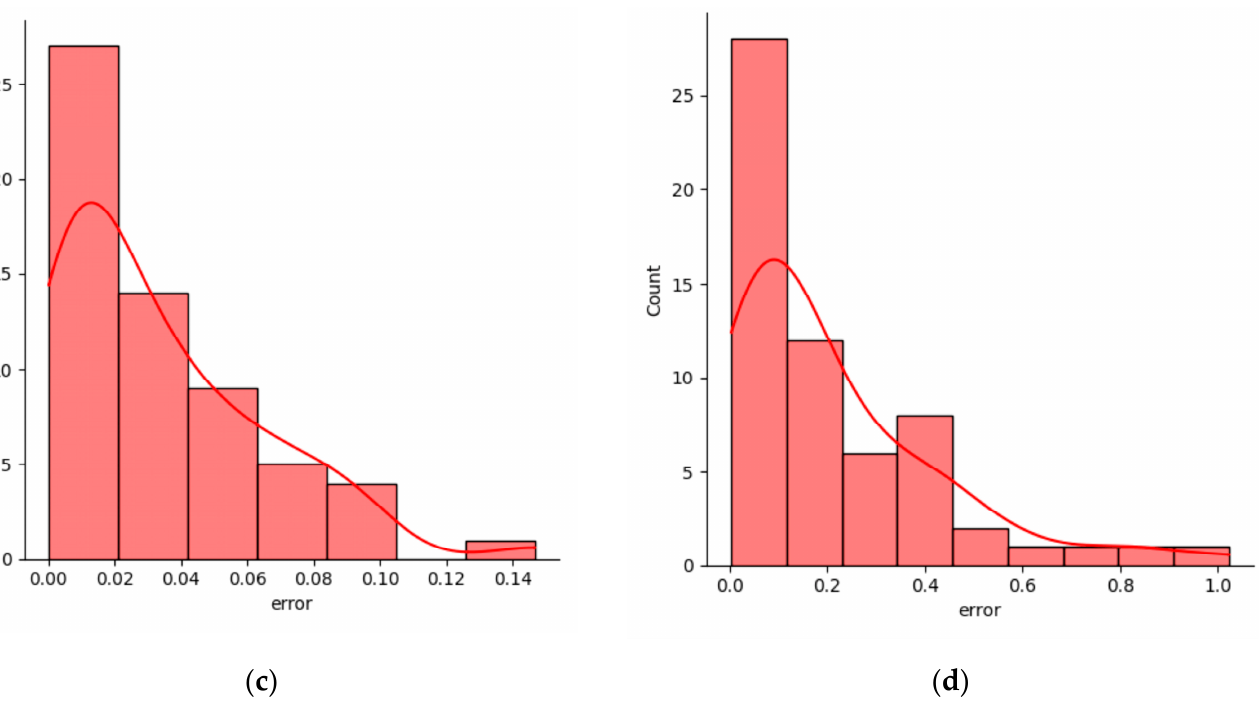
Figure 8. Histogram of the error distribution of predicted and actual values for the four datasets. ( a ) Histogram of the error distribution between predicted and actual values for the spring dataset; ( b ) histogram of the error distribution between predicted and actual values for the summer dataset; ( c ) histogram of the error distribution between predicted and actual values for the autumn dataset; ( d ) histogram of the error distribution between predicted and actual values for the winter dataset.